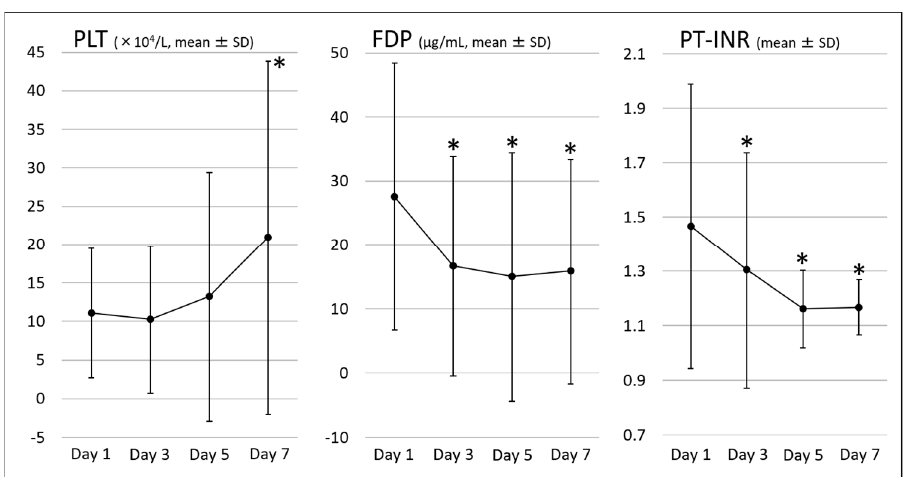
Figure 3. Parameters related to disseminated intravascular coagulation. PLT, platelet; FDP, fibrin degradation product; PT-INR, prothrombin time-international normalized ratio; * p < 0.05 vs. baseline.